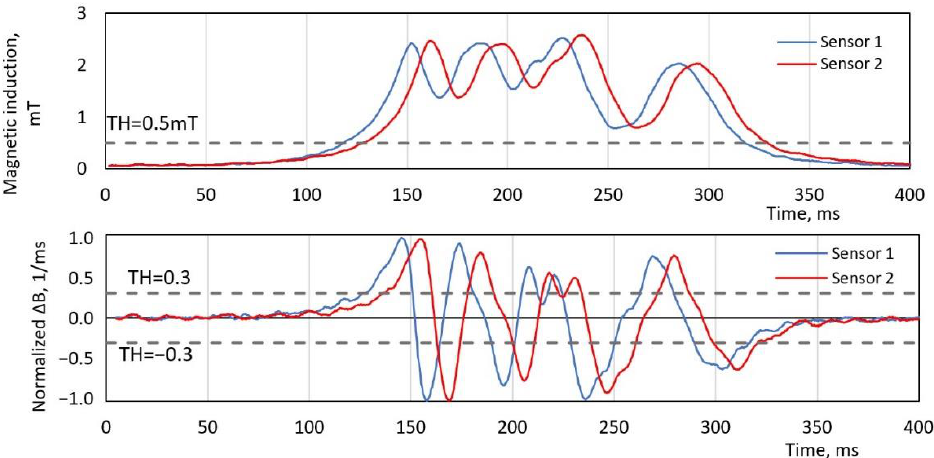
Figure 4. An example of two sensor readings with speed estimation method 1 and method 2. The threshold value (TH) for the magnetic magnitude signal ( top ) and for the first derivative of the magnetic magnitude ( bottom ).